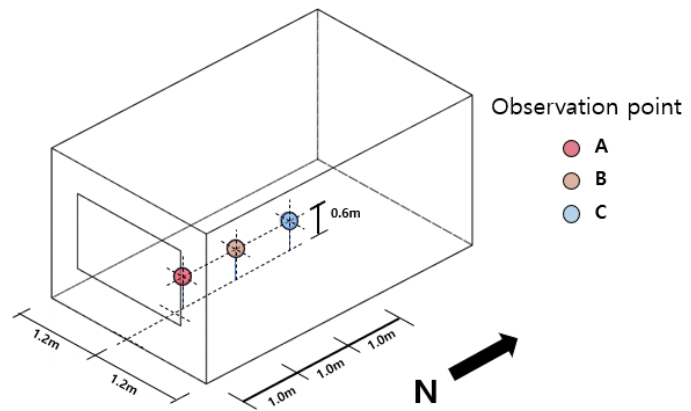
Figure 7. Defined calculation points in the room.